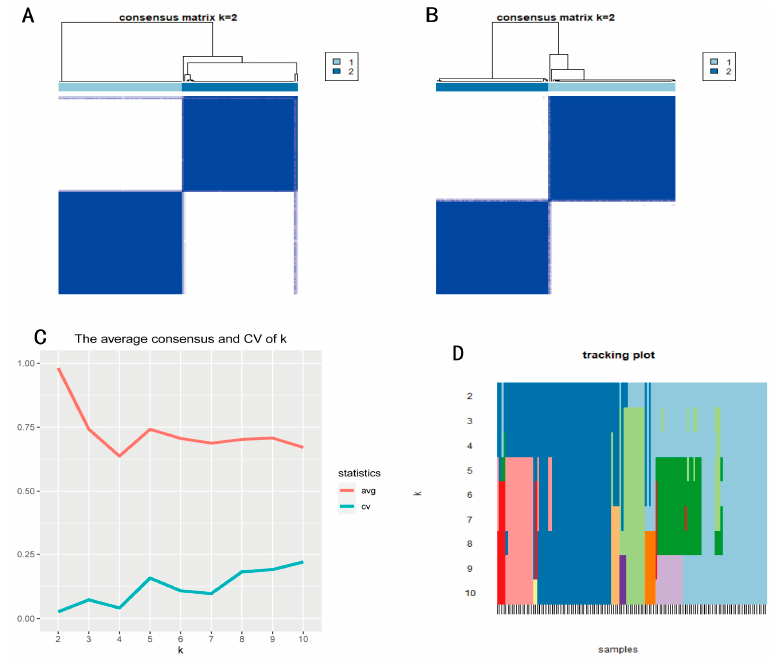
Figure 2. ( A ) Consistency cluster analysis of PAAD samples based on the PAM algorithm. ( B ) Consistency cluster analysis of PAAD samples based on the K-means algorithm. ( C ) Mean coefficient of consistency and coefficient of variation. ( D ) Consistency cluster matrix heat map for k = 2. In the consistency clustering matrix heat map, the values corresponding to the perfect consistency matrix are displayed in blue with white backgrounds on the diagonal blocks on the color-coded heat maps. The results of the PAM and K-means clustering algorithms